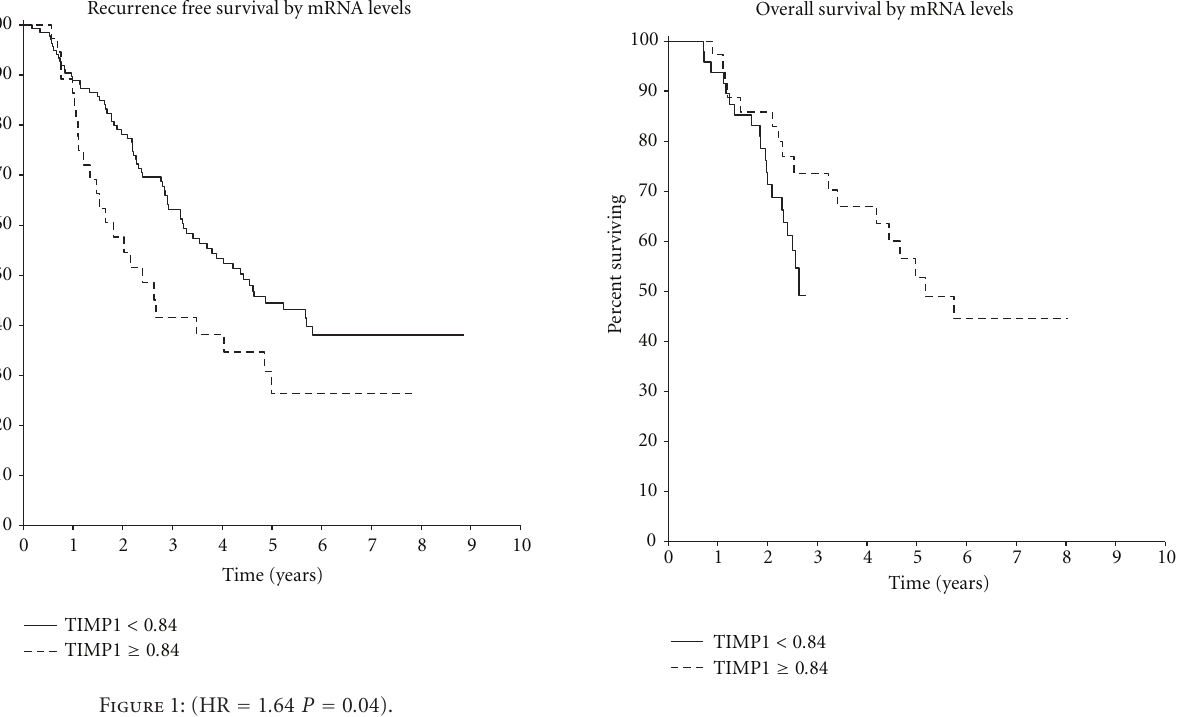
Figure 2: (HR = 1 . 29 P = 0 .